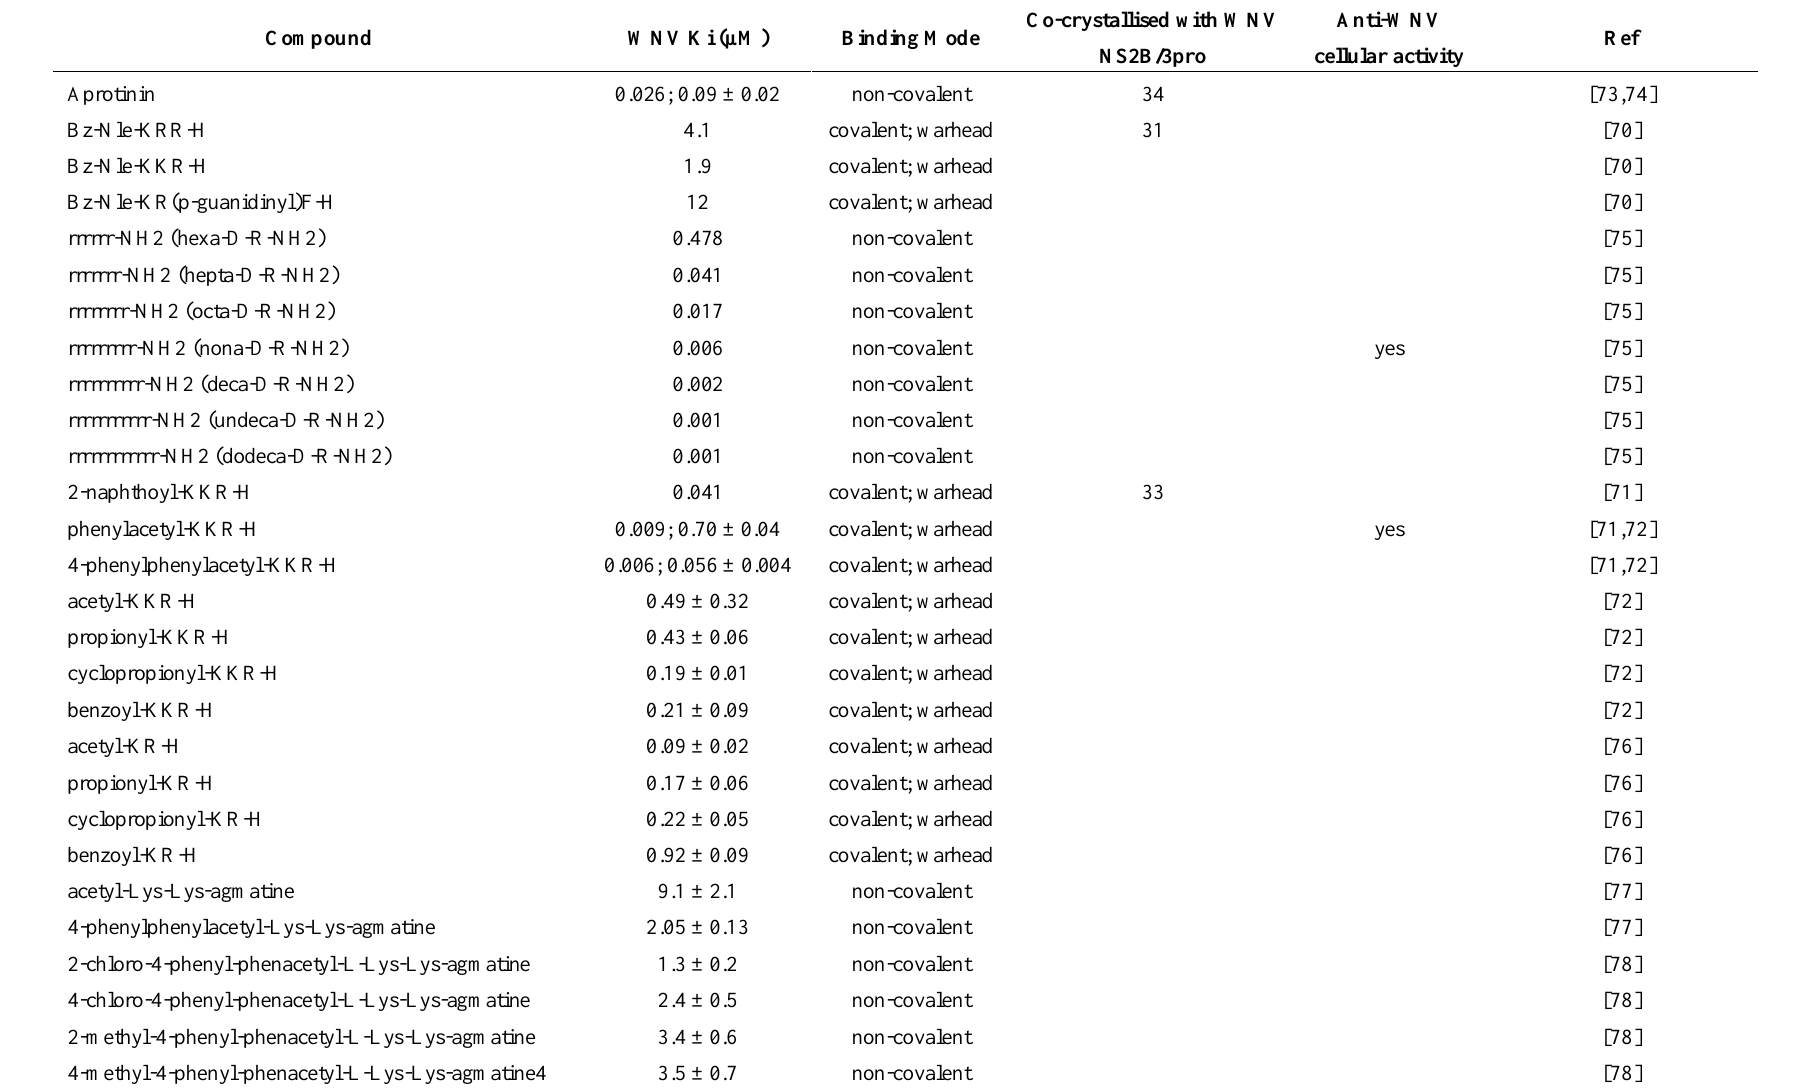
Table 1. List of WNV NS2B/3pro peptidic